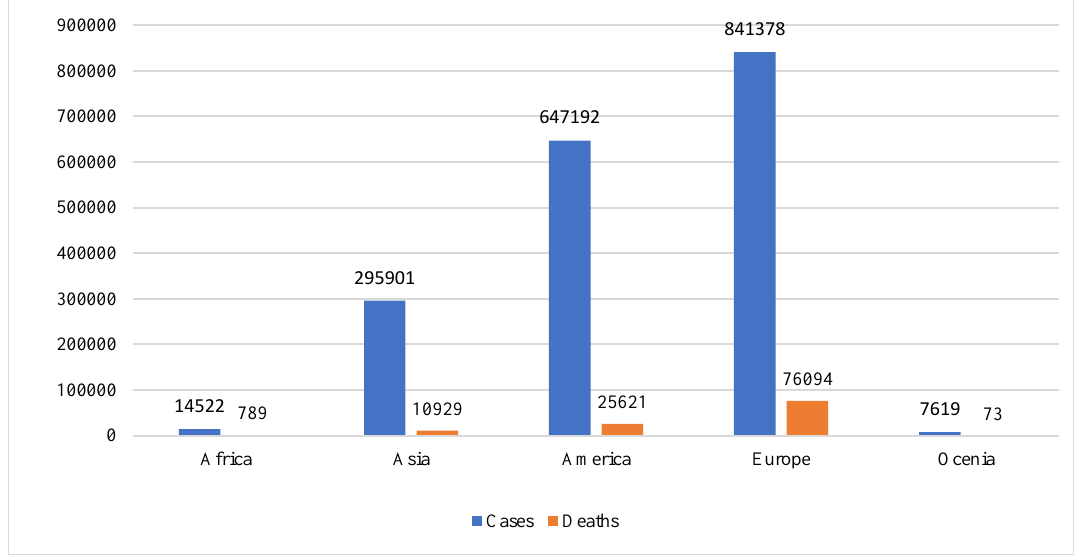
Figure 1. COVID-19 cases and deaths worldwide, as of 13 th April